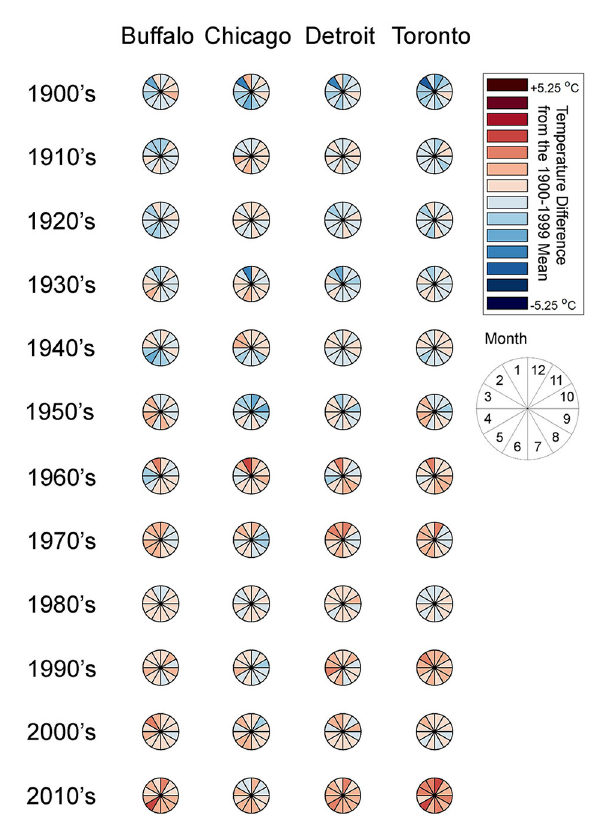
FIGURE5 Colorwheels of the 10-year mean monthly temperature difference from the 120-year (1900–2019) mean for Buffalo, Chicago, Detroit, and